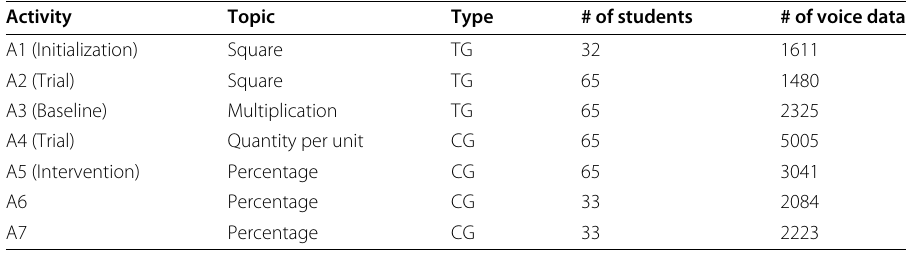
Table 5 Summary of data